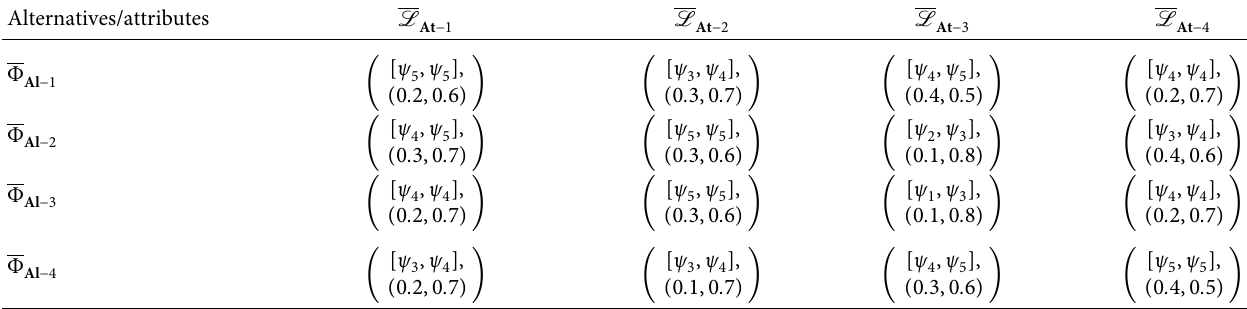
Table 13: Decision matrix provided by expert � R 3 in terms of CIULNs.